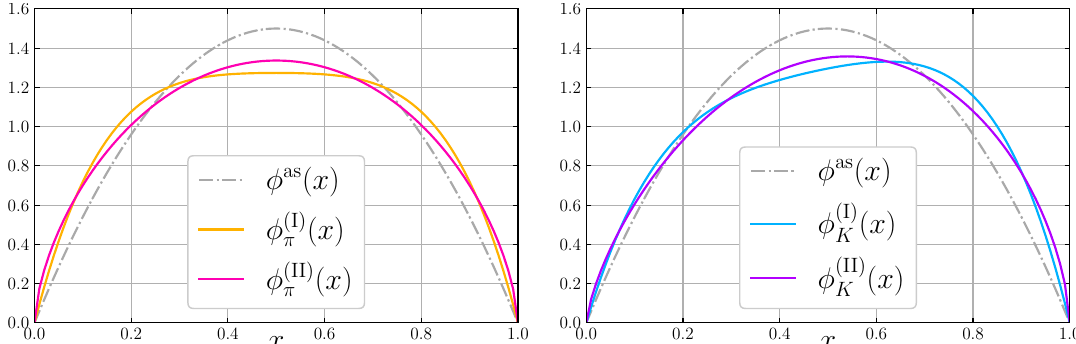
Figure 11 . The truncated Gegenbauer expansion (5.2a) and the power-law parametrization (5.2b) at (cid:22) = 2 GeV obtained using our results for a M and a M . The left panel shows the resulting DAs 1 2 for the pion, which are symmetric under x $ 1 (cid:0) x , while the results for the kaon DA on the right panel are slightly skewed towards the strange quark due to (cid:13)avor symmetry breaking. In all cases the deviation from the asymptotic shape is